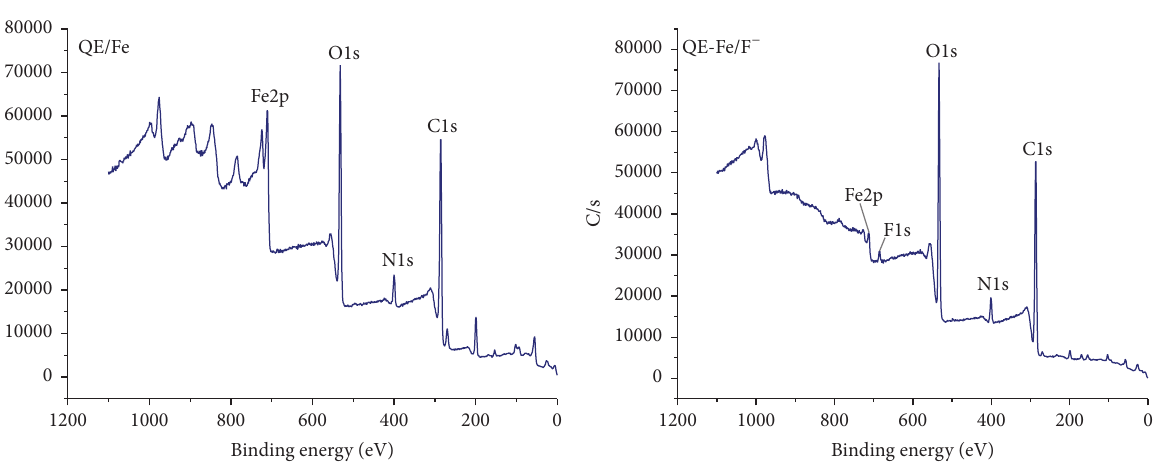
Figure 4: XPS spectrums of QEFe and QEFe/F − .